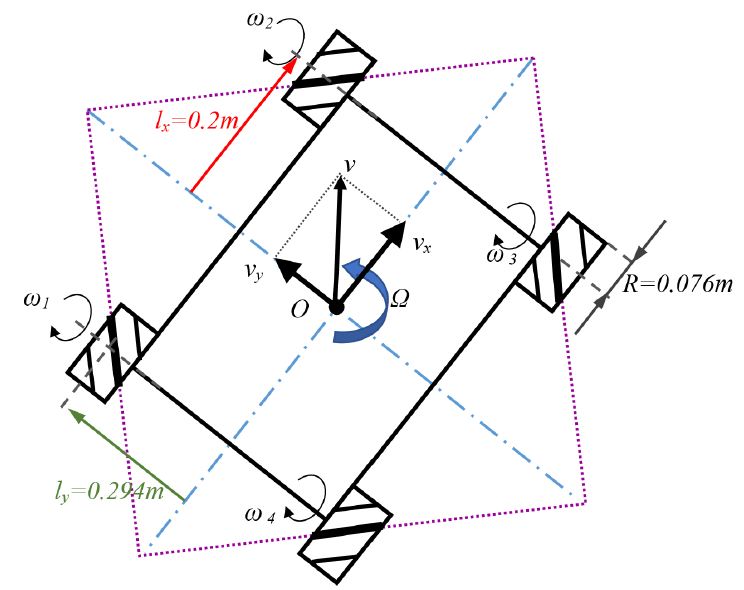
Figure 3. The robot coordinate system and